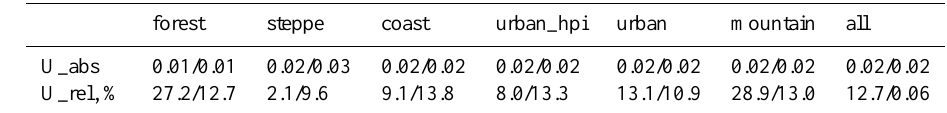
Table 2. The absolute (U_abs) and relative (U_rel) uncertainties between ADV and ASRVN surface reflectances at 555/659nm, calculated for all collocated pixels in different surface type groups.